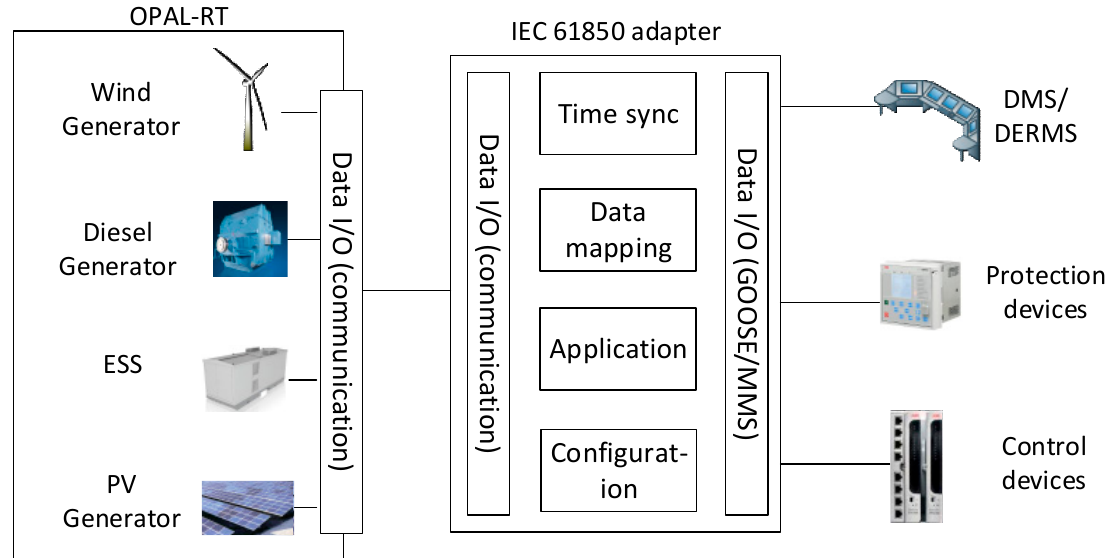
Figure 4. A schematic diagram of the proposed communication adapter for DERs.